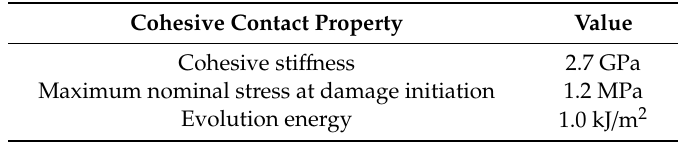
Table 3. Cohesive contact properties of the studied waterproof membrane.